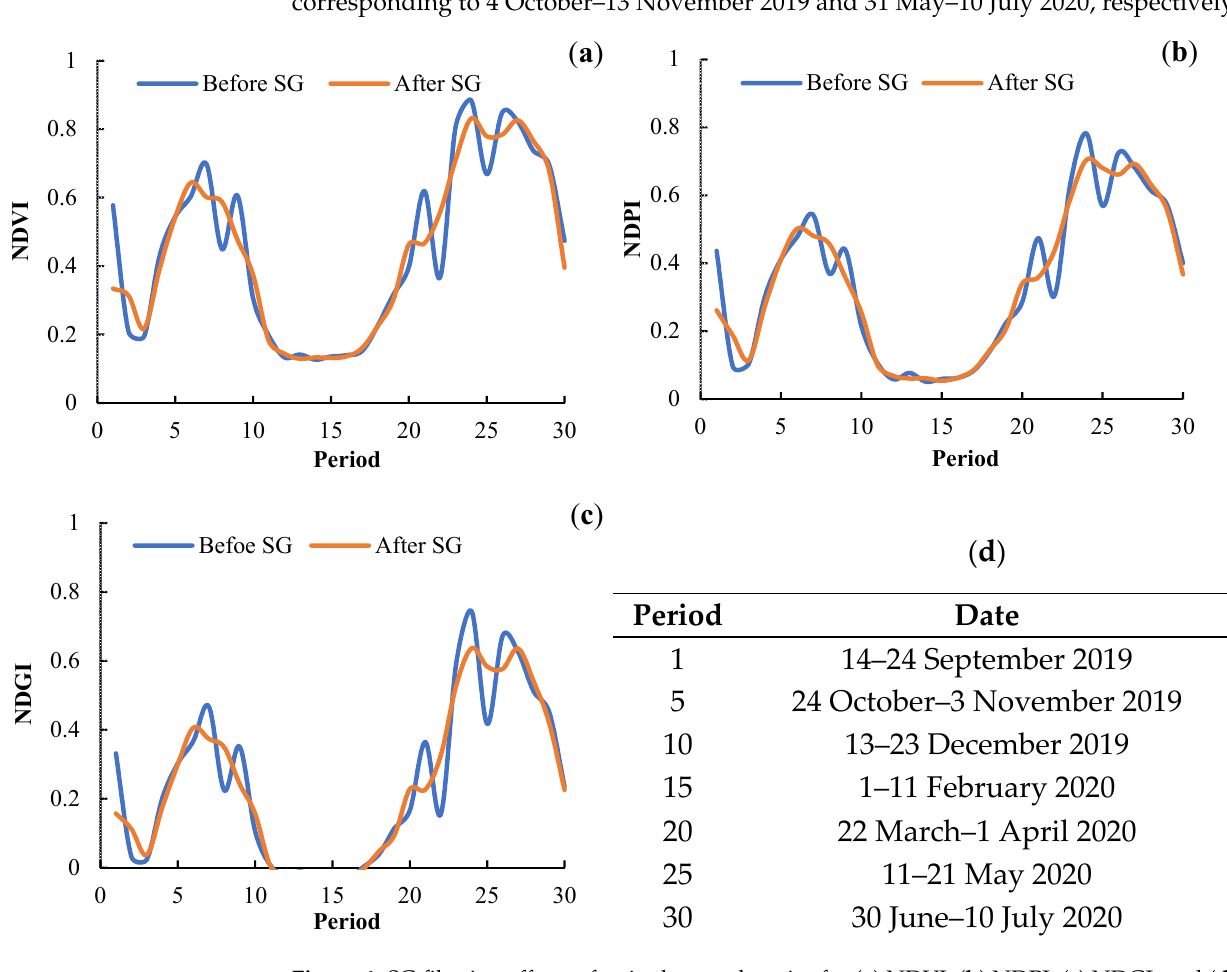
Figure 4. SG filtering effects of a single sample point for ( a ) NDVI, ( b ) NDPI, ( c ) NDGI, and ( d ) the dates corresponding to period number.